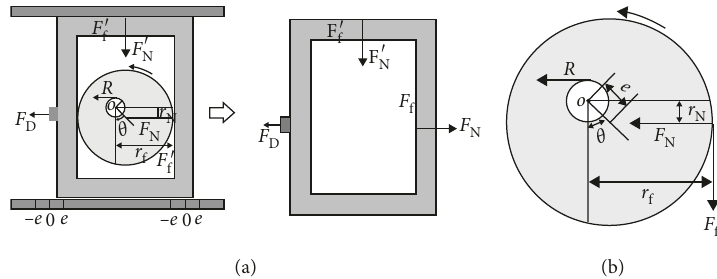
Figure 2: Force analysis diagram of CRAD: (a) CRAD mechanism force diagram; (b) force diagram of eccentric disc cam.